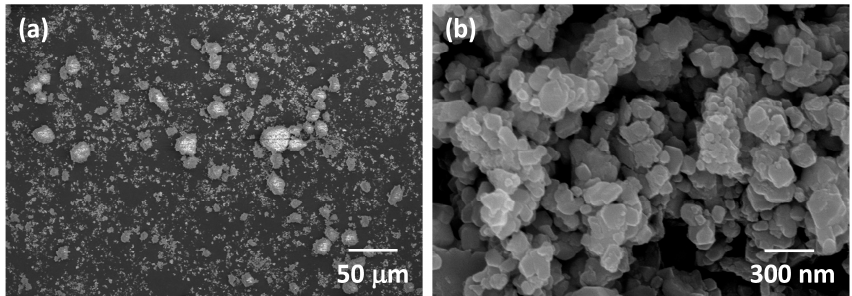
Figure 1. SEM micrographs of ( a ) secondary and ( b ) primary particles of as-received Tosoh Zpex Smile powder.